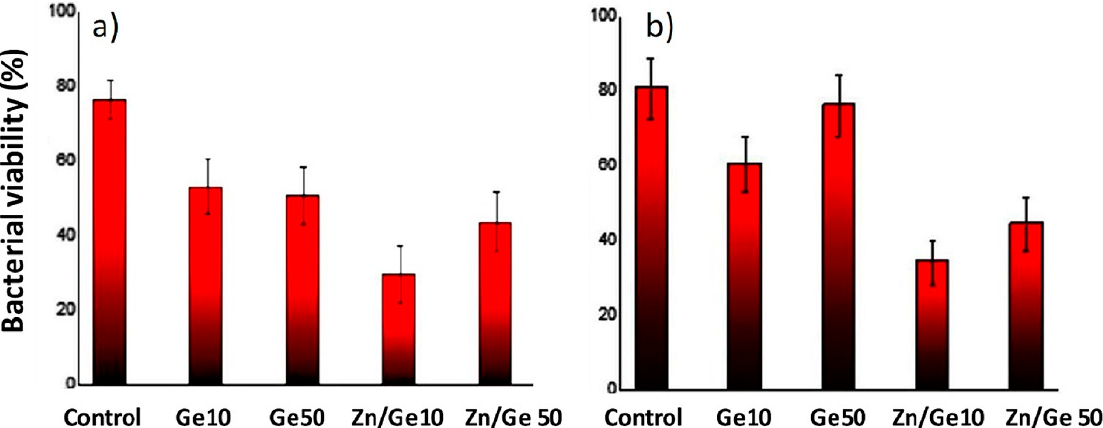
Figure 8. S. aureus ( a ) and E. coli ( b ) viability against neat geranium oil (Ge) and geranium oil/ZnO nanocomposites (Zn/Ge) prepared via plasma polymerization with radio frequency powers of 10 W (Ge 10 and Zn/Ge 10) and 50 W (Ge 50 and Zn/Ge 50). Adapted from [47], copyright 2019, with permission from Springer Nature.